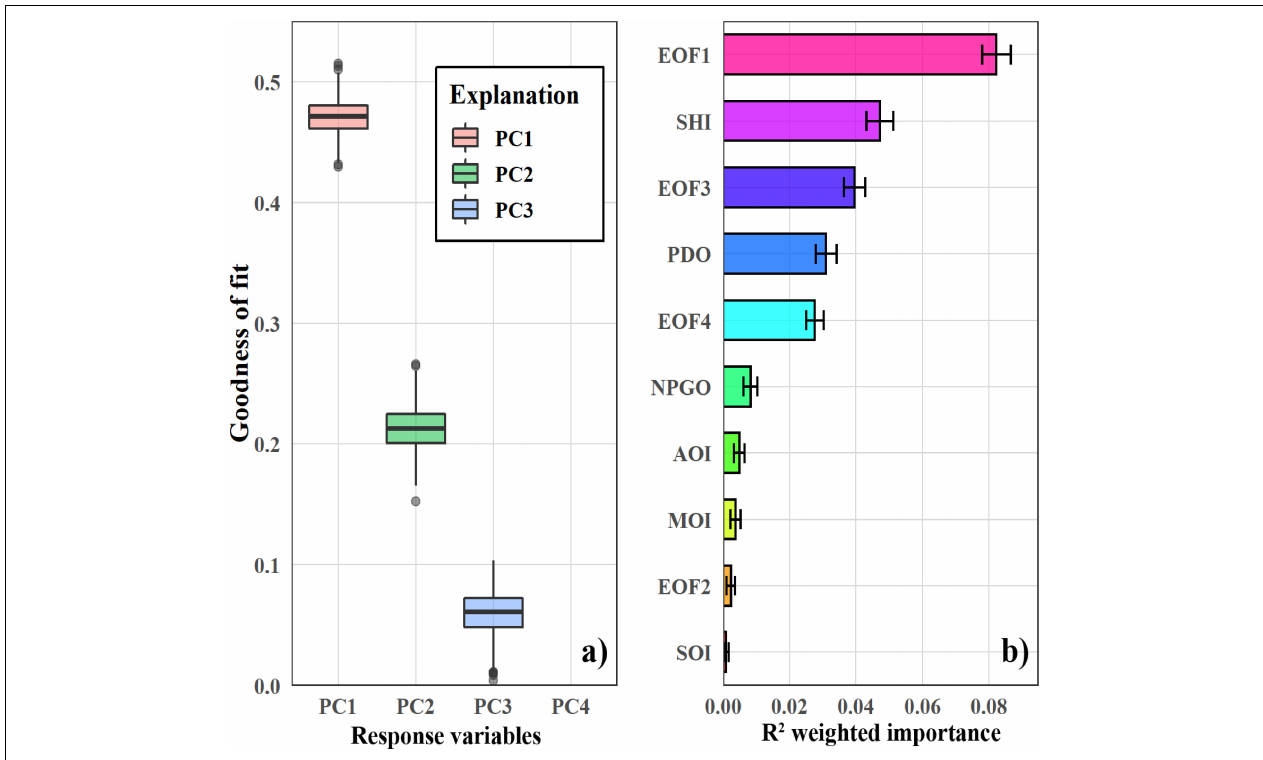
FIGURE 7 | Gradient forest analysis shows (A) model performance (goodness-of-fit R 2 ) for principal components (PCs) and (B) weighted importance of modes of empirical orthogonal functions (EOFs) and climatic indices (CIs) on PCs. Error bars represent standard deviations from 1,000 model runs.